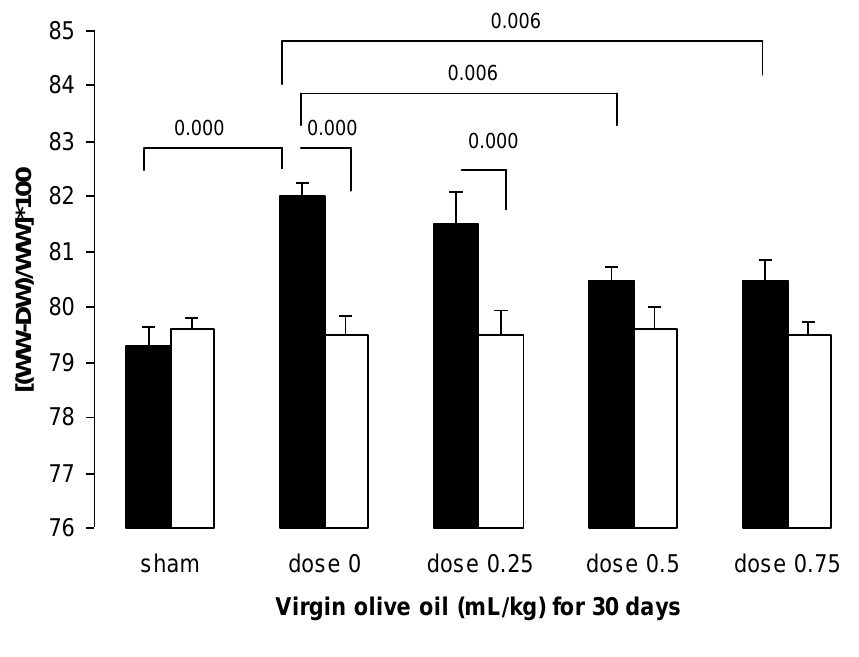
FIGURE 4. Brain water content in various experimental groups including left and right hemisphere of sham-operated, 0, 0.25, 0.5, and 0.75 mL/kg of VOO (n = 6).